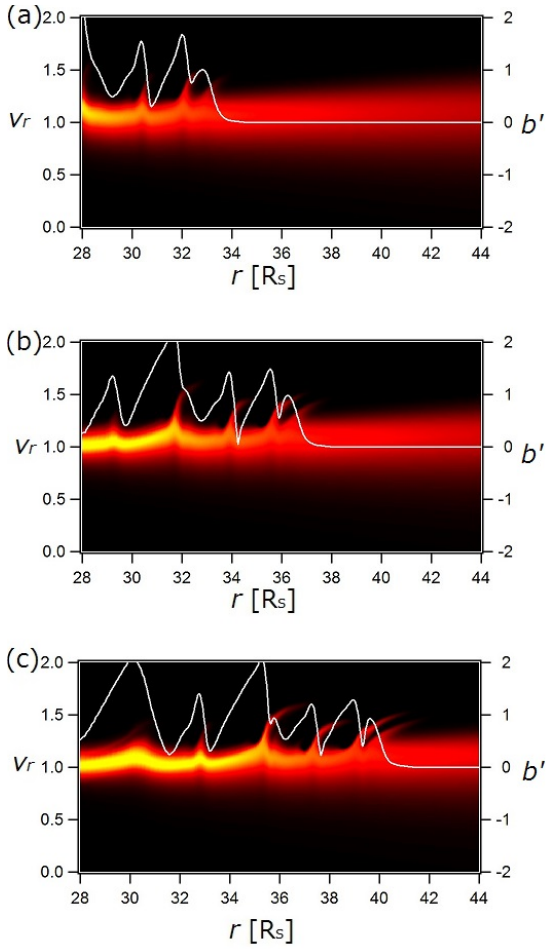
Fig. 3. The snapshot of g 0 at (a) t = 16 . 5, (b) t = 19 . 25, and (c) t = 22 . 0 in Run B. The white lines indicate | b 0 |